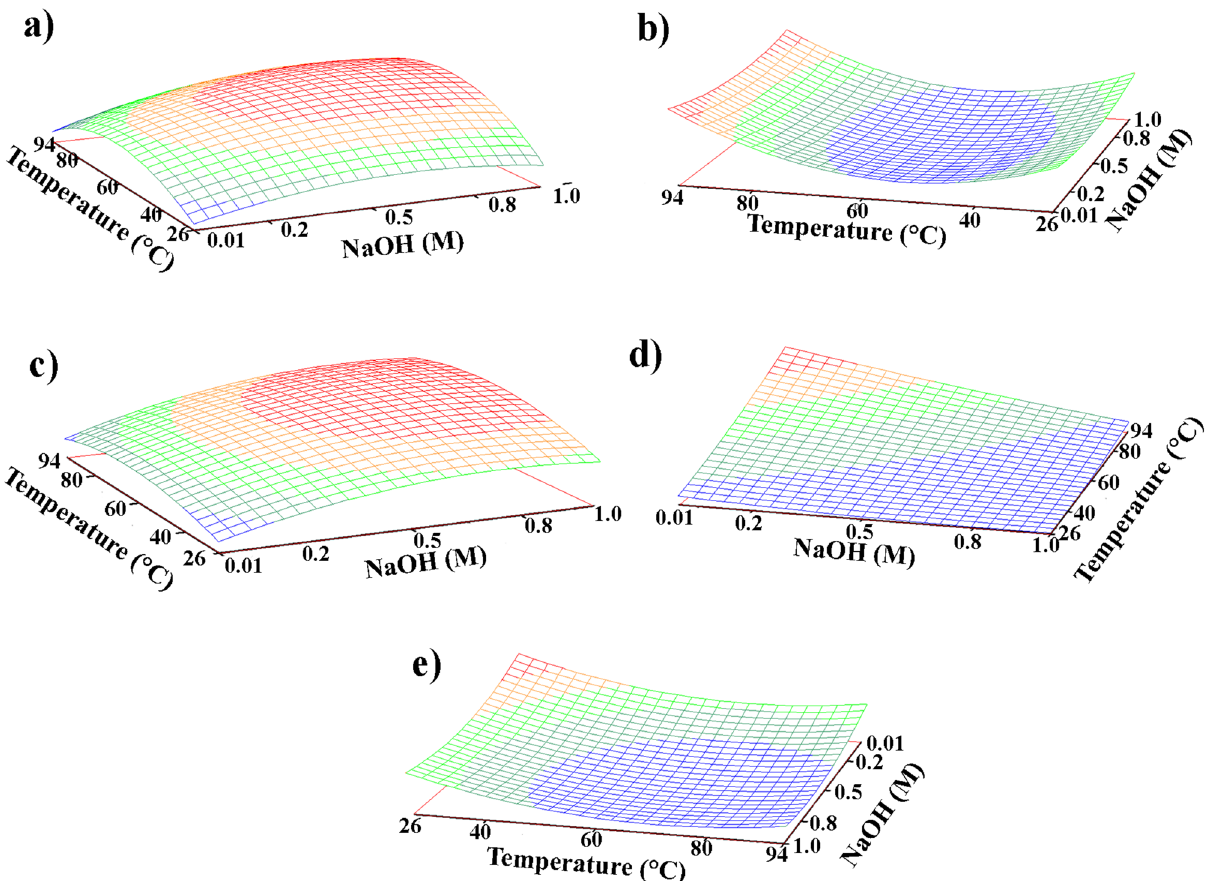
Figure 2. Response surfaces for ( a ) maximum Cl − extraction (t = 85.0 h); ( b ) minimum Fe lixiviation (t = 89.6 h); ( c ) maximum goethite content (t = 99.4 h); ( d ) maximum hematite content (t = 124.0 h); ( e ) minimum akaganeite content (t = 99.4